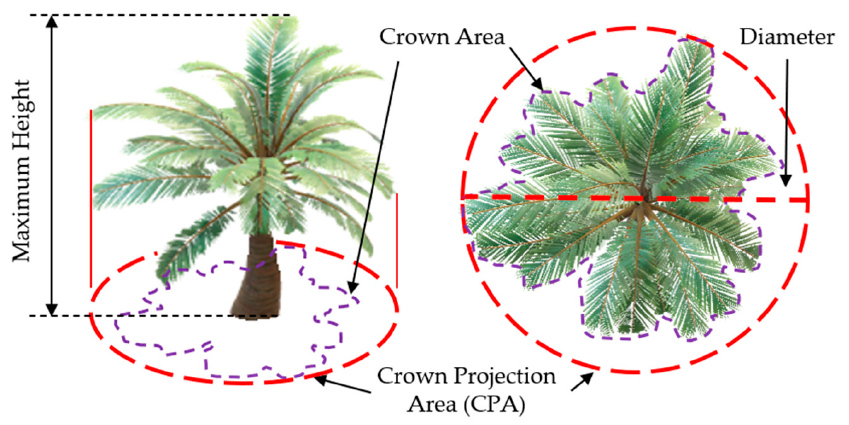
Figure 8. Illustration of height, crown area, and CPA.